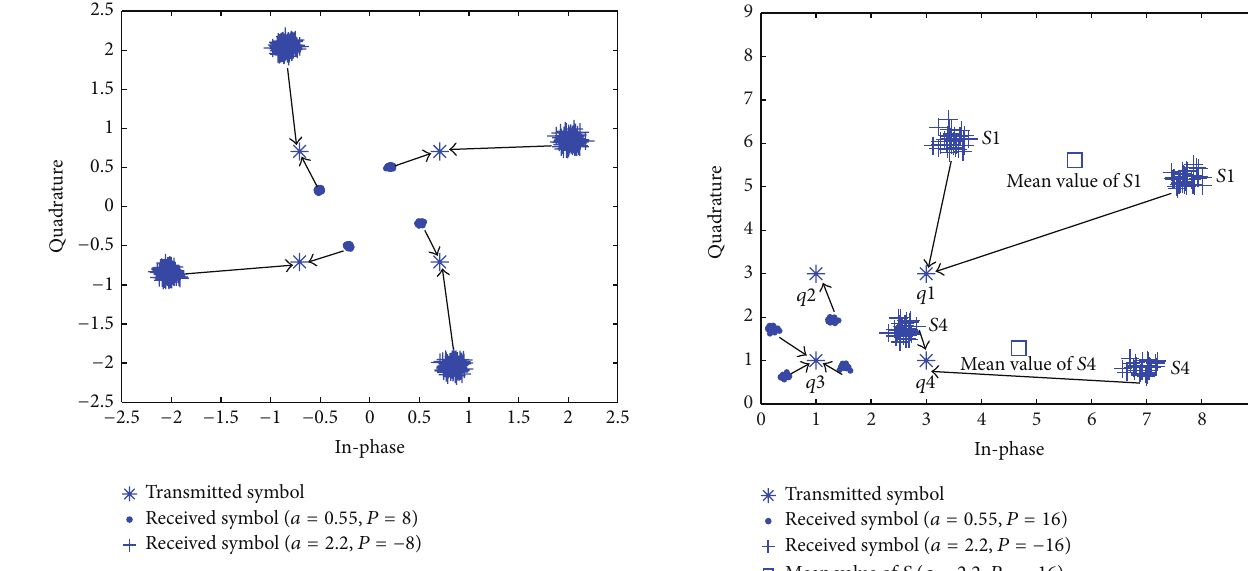
Figure 1: QPSK symbols with different fading coefficients.